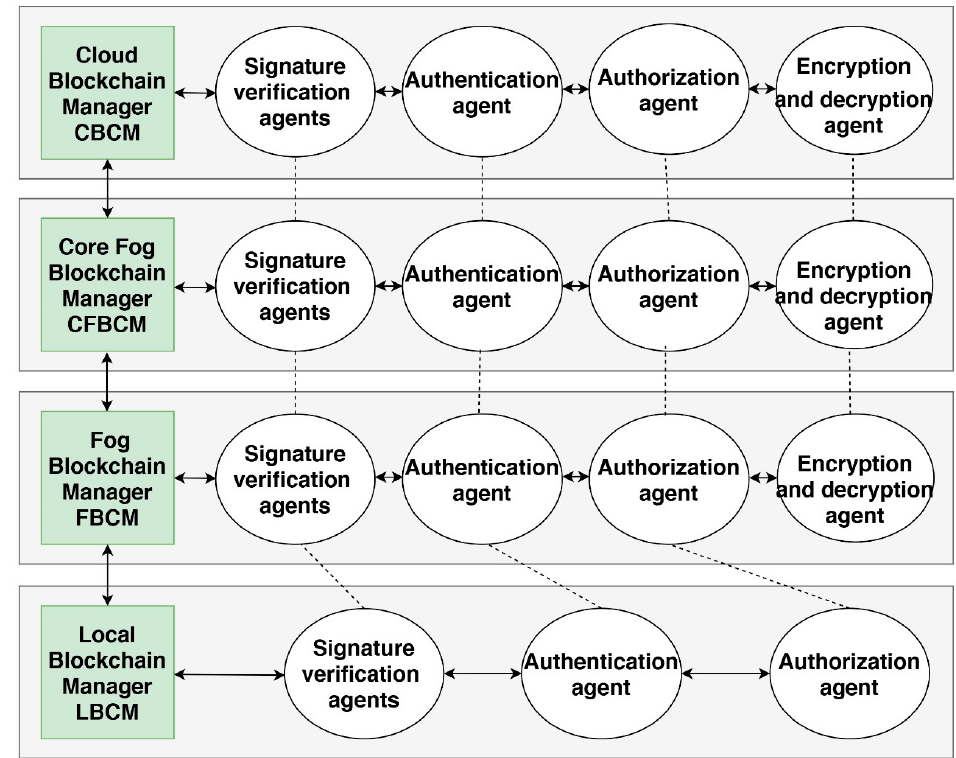
Figure 2. Proposed blockchain-based framework for secure Internet of Things (IoT) access control.